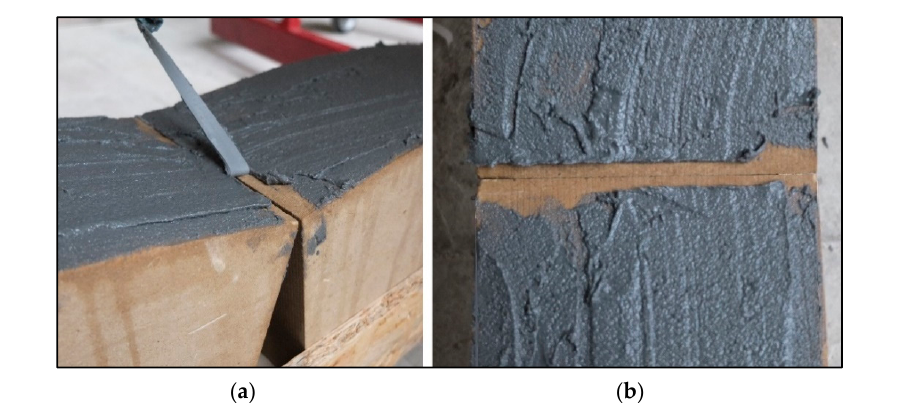
Figure 8. Detail of the hinge achievement: ( a ) butyl tape removal and ( b ) hinge achievement.